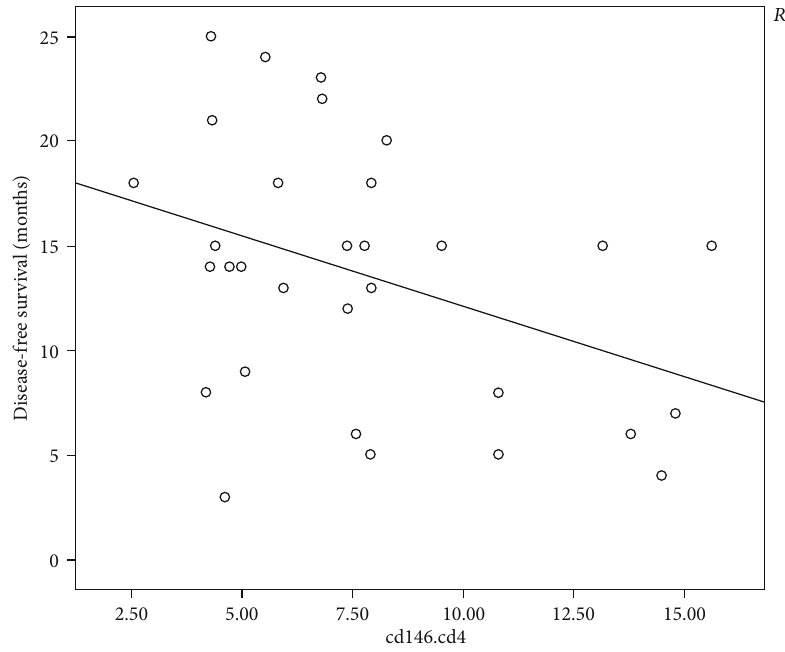
Figure 6: Scatter plot of the relation between CD146 + CD4 + cells and